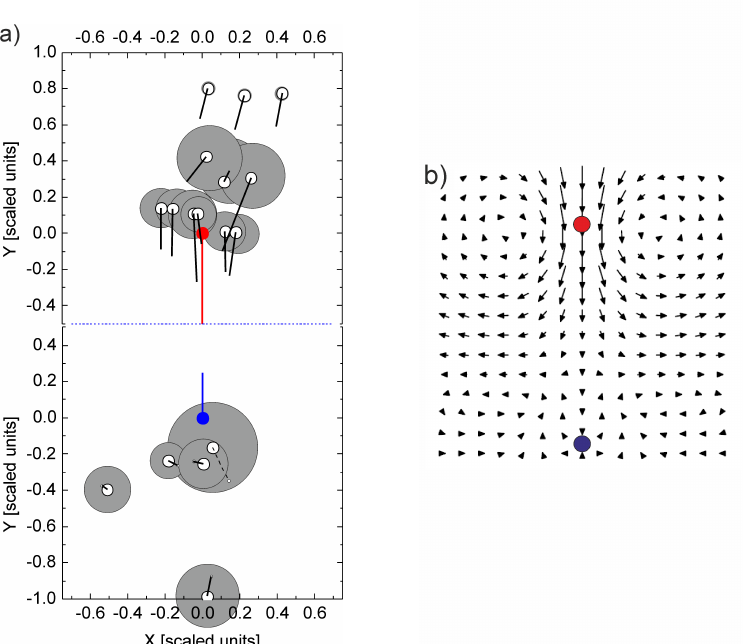
Figure 6. Advective flow around disclinations in a ± 1 pair. ( a ) Flow field determined experimentally using the fluorescence bleaching method. The velocity bars are normalized with respect to that of the + 1 defect (see text). The motion of the s = + 1 is accompanied by the flow in the same direction of motion. In contrast, the flow is nearly absent in the vicinity of the s = − 1 defect. ( b ) Numerical flow velocity field showing the formation of the flow vortices around the s = + 1 defect. Image ( b ) reproduced with permission from Svenšek and Žumer [24], copyright American Physical